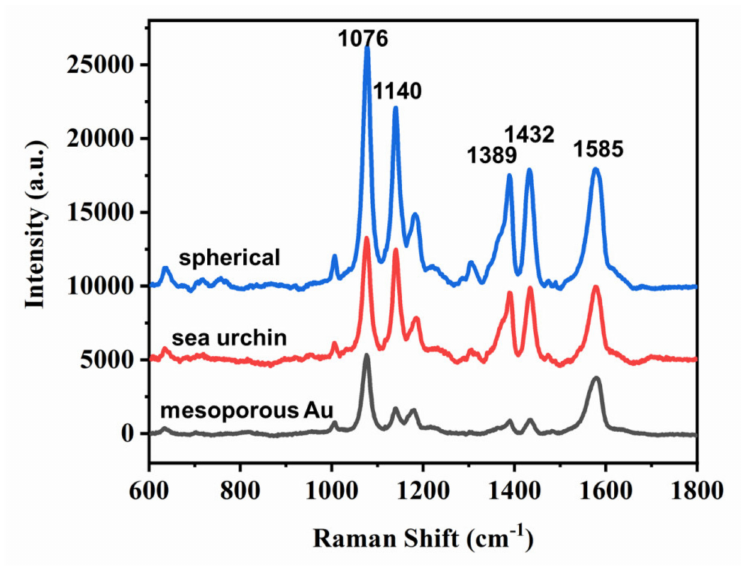
Figure 4. SERS spectra of 10 − 4 M 4-ATP molecules with different substrate materials.